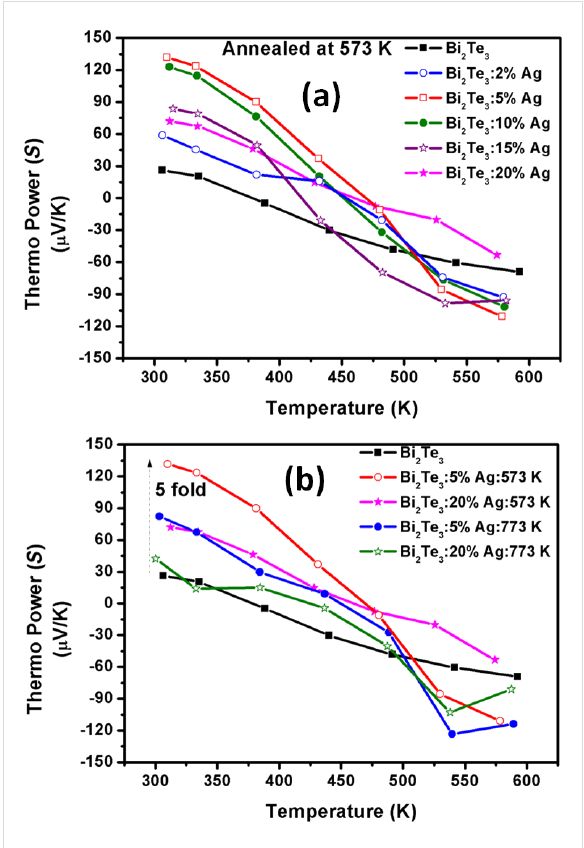
Figure 6: Temperature dependent thermo power measurement ( S ) of (a) Bi 2 Te 3 with (0, 2, 5, 10, 15, 20%) Ag content annealed at 573 K, and (b) comparison of (0, 5, 20%) annealed at 573 K with (5, 20%) 773 K samples in the temperature range 300–600